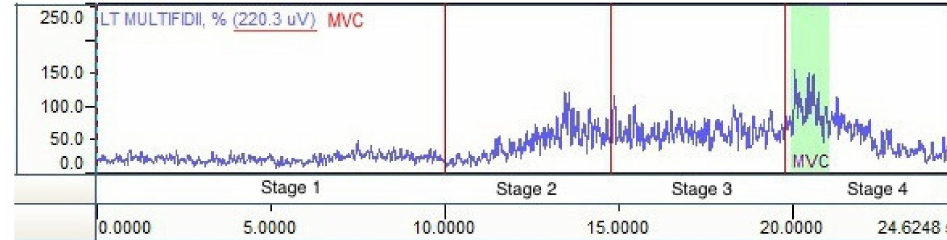
Figure 3. sEMG record [%MVC] following signal amplitude normalization. Author’s